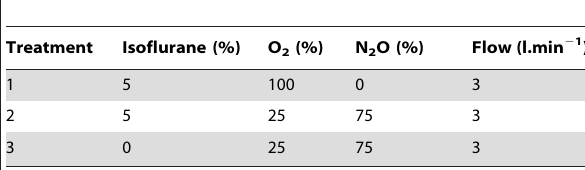
Table 2. Composition and flow rate of the anaesthetic mixtures used for anaesthesia induction – pilot